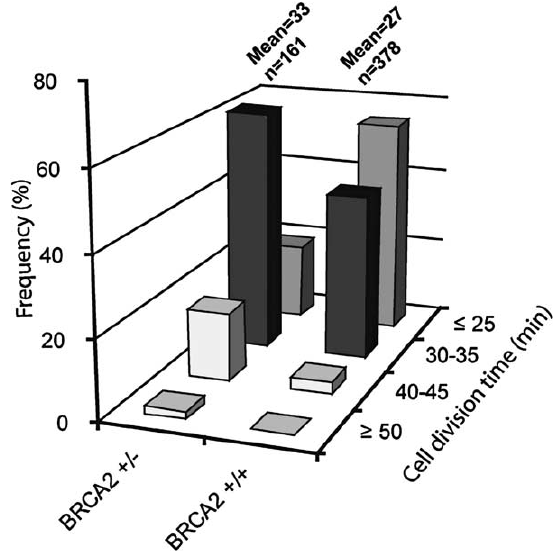
Fig. 3. Frequency distribution of the cell division time of BRCA2 + / − versus BRCA2 + / + unmodified primary human fi- broblasts. The BRCA2 heterozygous mutant cells have a significant longer cell division time than the BRCA2 wild type cells, 6 min on average, indicating that the delay is associated with the mutation sta- tus in the BRCA2